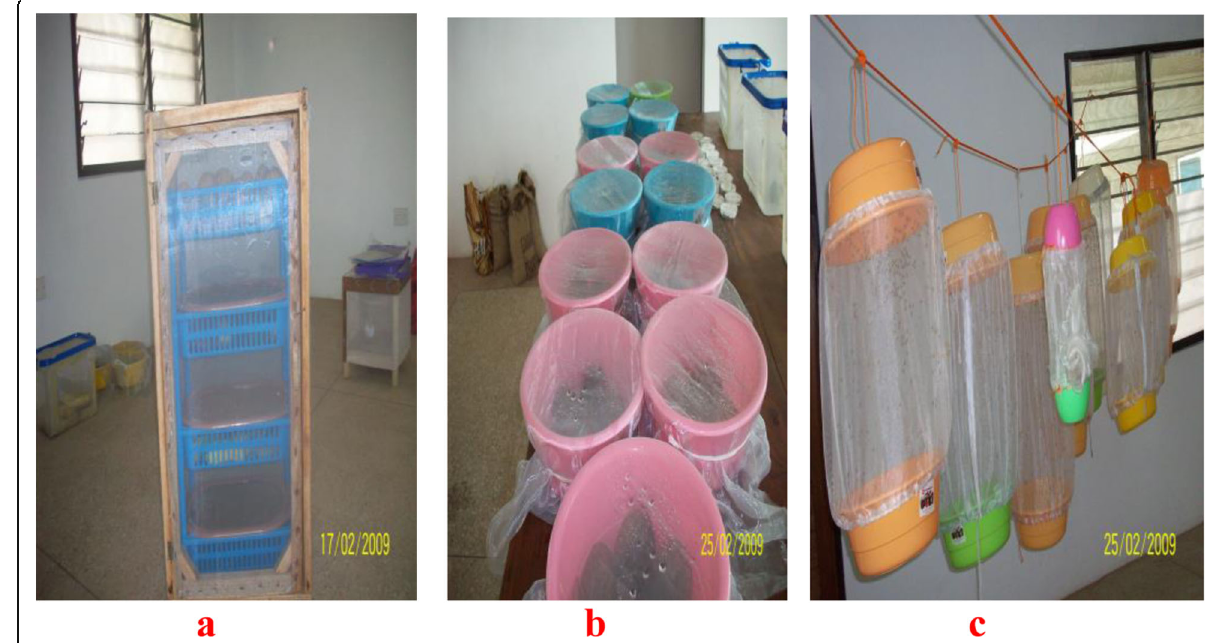
Fig. 1 Incubation of mango/fruits on ( a ) plastic racks and in ( b ) plastic bowls for rearing flies, Adult fruit flies holding cages ( c